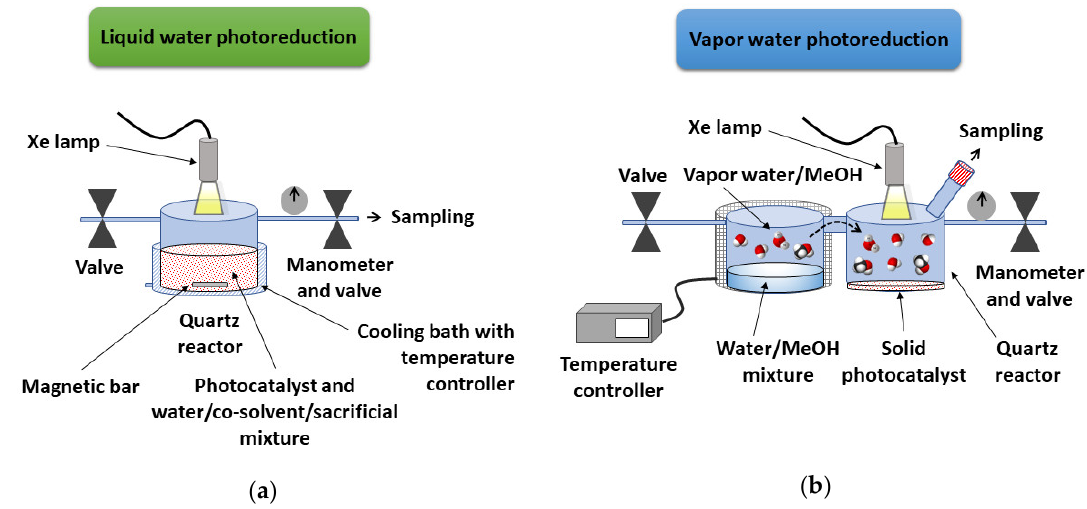
Figure 2. Experimental setups for liquid water ( a ) and vapor water ( b ) catalytic photoreductions.